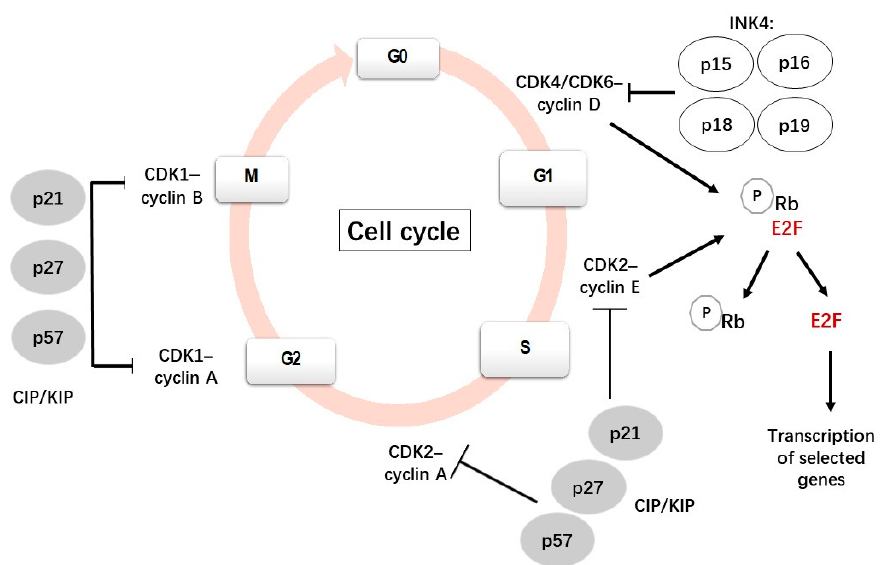
Figure 1. A scheme showing the canonical cell cycle and its main regulatory mechanisms [8,9]. Each CDK is able to associate with different cyclins with a specific role in each phase. For instance, when a cell is withdrawn from the quiescent state and enters the G1 phase, D-type cyclins (D1, D2, D3) bind and activate CDK4/6; these active complexes phosphor- ylate and inactive the retinoblastoma (Rb) protein family, which plays a negative regula- tion of the cell cycle. The phosphorylation of the Rb protein leads to the release of tran- scription factor E2F1 from its transcriptionally repressive complex, allowing the transcrip- tion of genes and the synthesis of the proteins necessary for DNA replication [10]. During the late G1 phase, cyclin E associates with CDK2 to progress through the S phase, subse- quently binding to cyclin A during the early S phase and promoting DNA synthesis and replication [7,11].